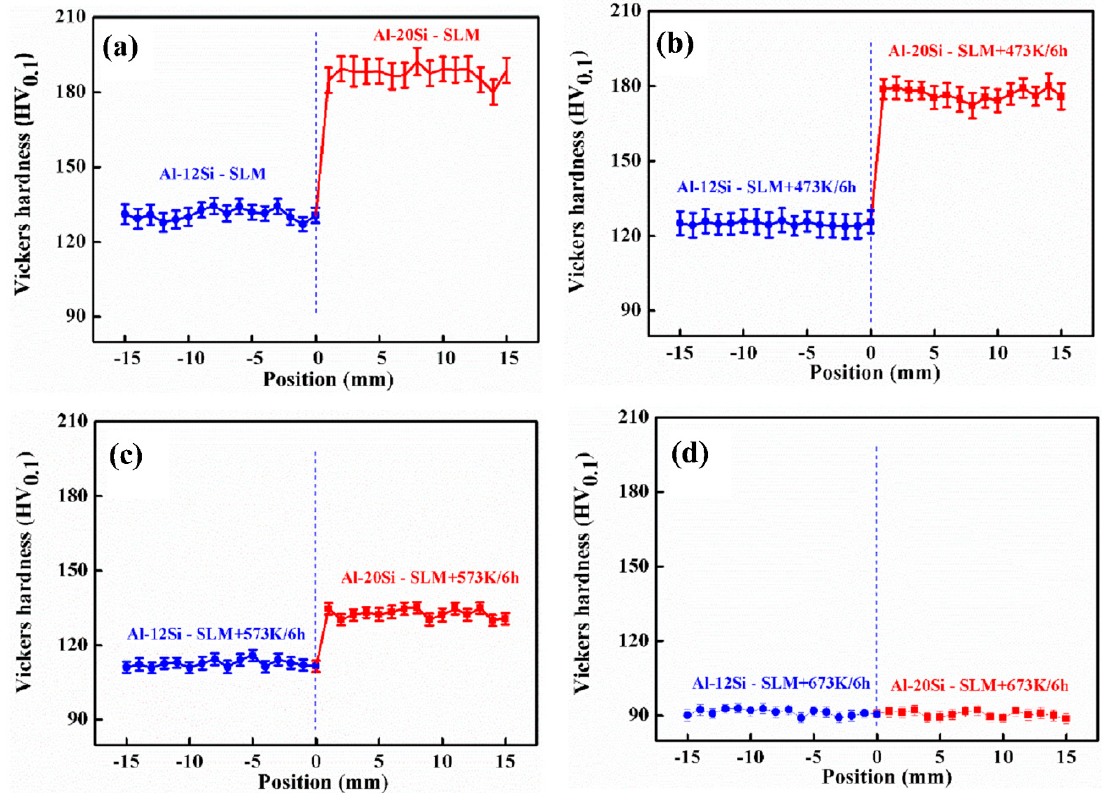
Figure 4. Vickers hardness of Al–(12-20)Si bi-materials: ( a ) SLM; ( b ) SLM + 473 K/6 h; (c) SLM + 573 K/6 h; (d) SLM + 673 K/6 h.